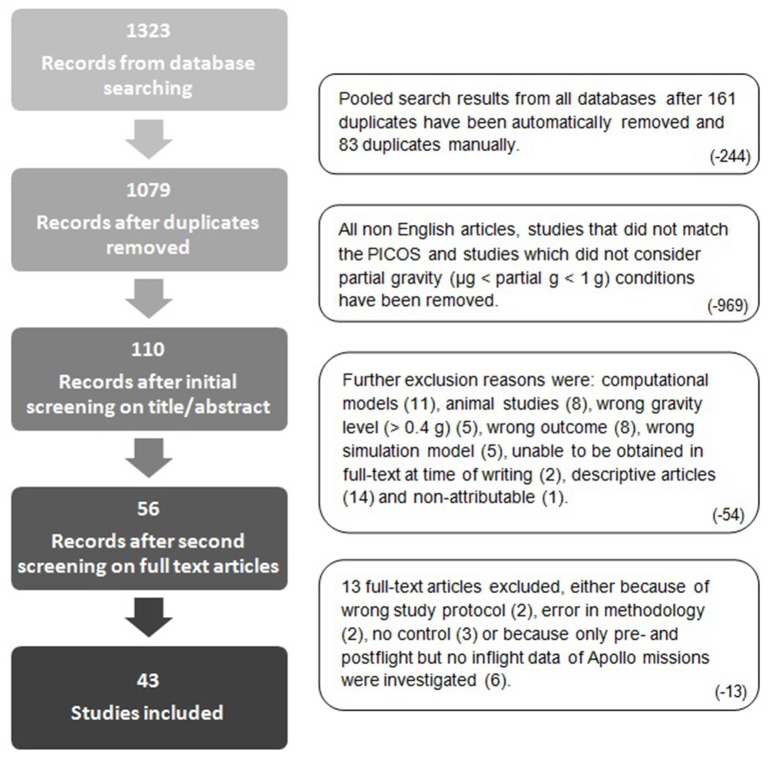
Search and screening strategy and numbers.